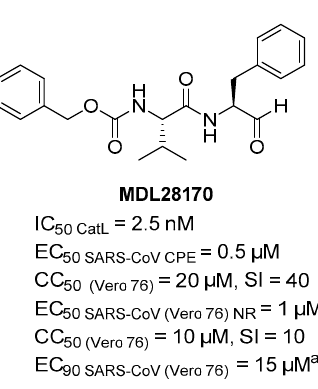
Figure 17. Chemical structure and biological activity of aldehyde MDL28170 as potent covalent reversible inhibitor of CatL and anti-CoV agents; a virus yield reduction assay (biological data from Ref. [108])